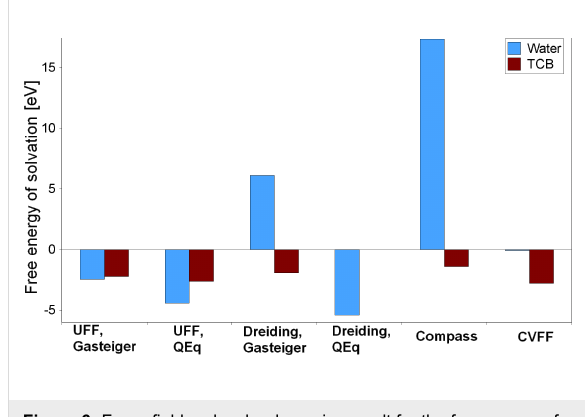
system size to 600 water molecules, the volume